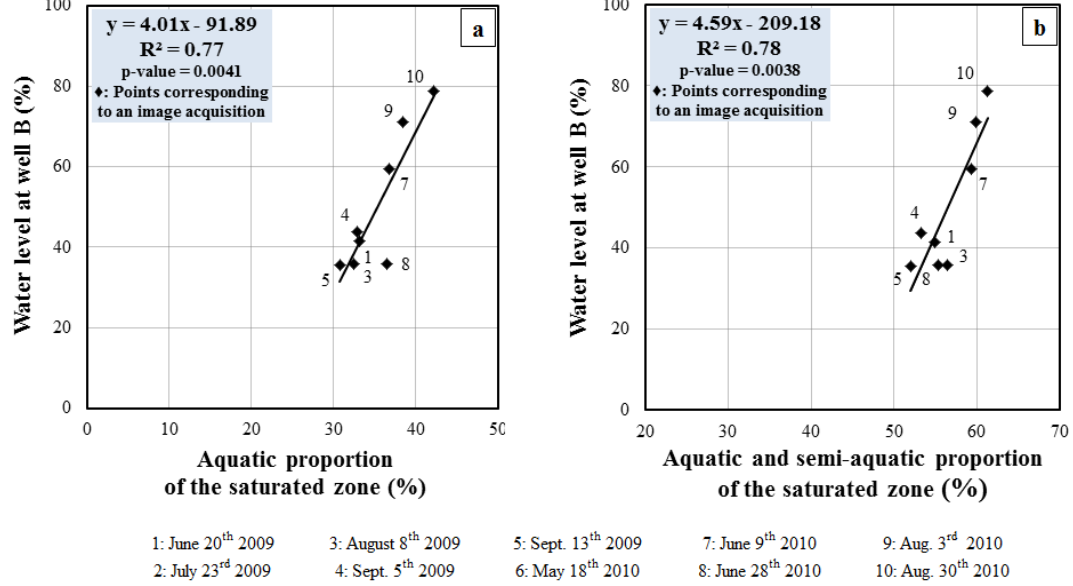
Figure 13. ( a ) Water level measured at well B compared to corresponding aquatic proportion of the site 2 saturated zone (derived from GeoEye-1 image classifications). ( b ) Water level measured at well B compared to corresponding aquatic and semi-aquatic proportion of the site 2 saturated zone. The range of measured water levels is displayed in percentages, 100% corresponding to the maximal water level value (0% to the